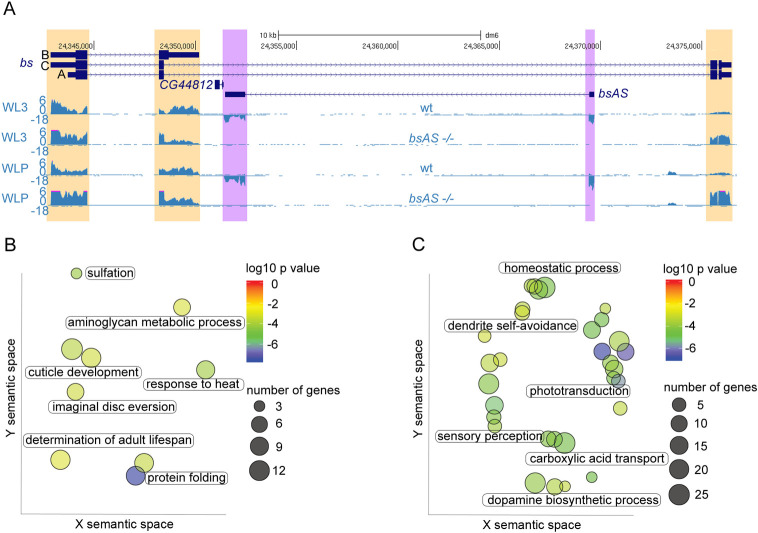
bsAS mutation induces overexpression of neural genes in wing imaginal discs.(A) Expression of bs locus in wt and bsAS -/- wings at L3 (upper panels) and LP (lower panels) –note that wt tracks coincide with tracks in Fig 1C–. Differences in expression between wt and mutant tissues are highlighted in purple for the lncRNA and in orange for the coding gene. The depletion of bsAS expression after bsAS TSS deletion is confirmed in the RNA-Seq experiments, as well as the consequent overexpression of the long bs isoform C. (B) Gene Ontology Term Enrichment analysis of downregulated genes in bsAS-/- WLPs. Few GO categories were enriched among downregulated genes in bsAS-/- LP wings, among them, cuticle development and imaginal disc eversion. (C) Gene Ontology Term Enrichment analysis of upregulated genes in bsAS-/- WLPs. Upregulated genes are enriched in categories mainly related to neural fates, such as phototransduction, sensory perception and dopamine biosynthesis. In (B) and (C), each spot represents an enriched category and labels are representative of clusters of categories; color of the spots represents the p value of enrichment; size of the spots represents number of genes belonging to each category. Axes represent semantic space from ReviGO [29].